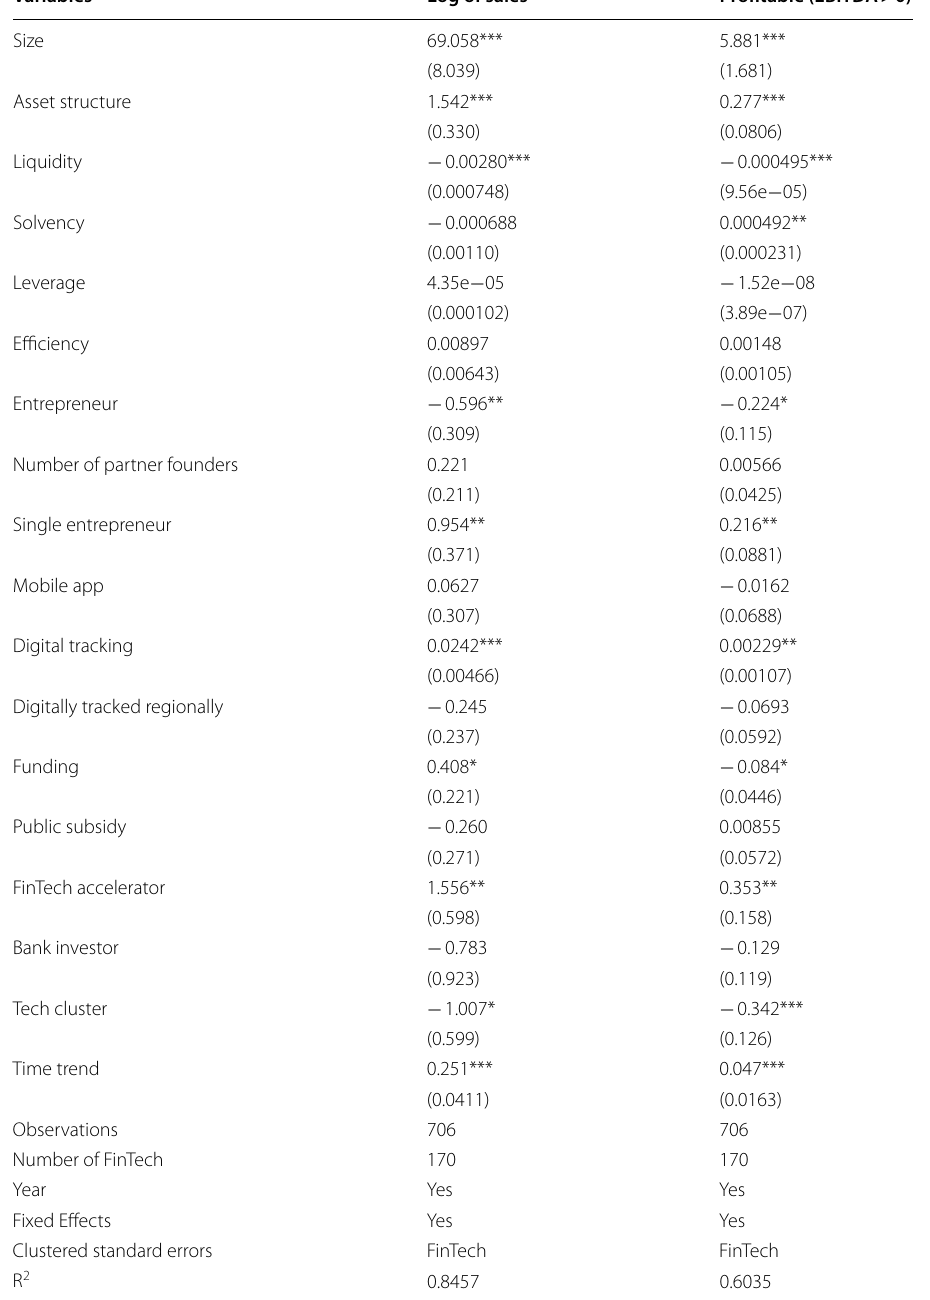
Table 11 Alternative performance measures: sales and